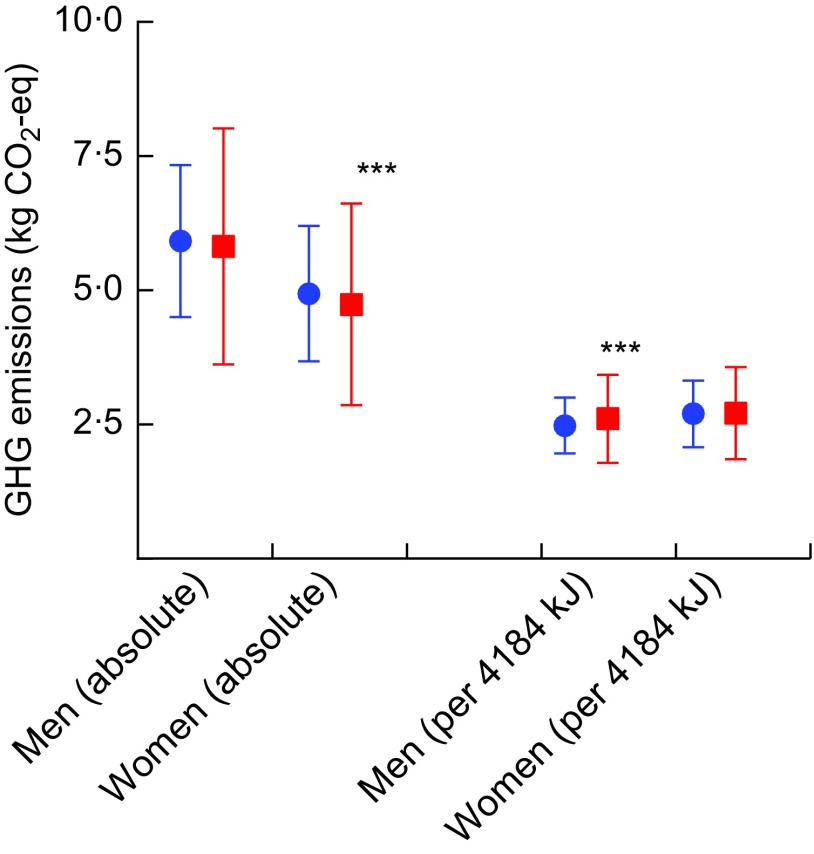
Greenhouse gas (GHG) emissions, absolute and per 4184 kJ (1000 kcal), at baseline () and follow-up () in the European Prospective Investigation into Cancer and Nutrition – Netherlands (EPIC-NL) cohort. Values are means with their sd represented by vertical bars. Significance level of paired t test: ***P < 0·0001